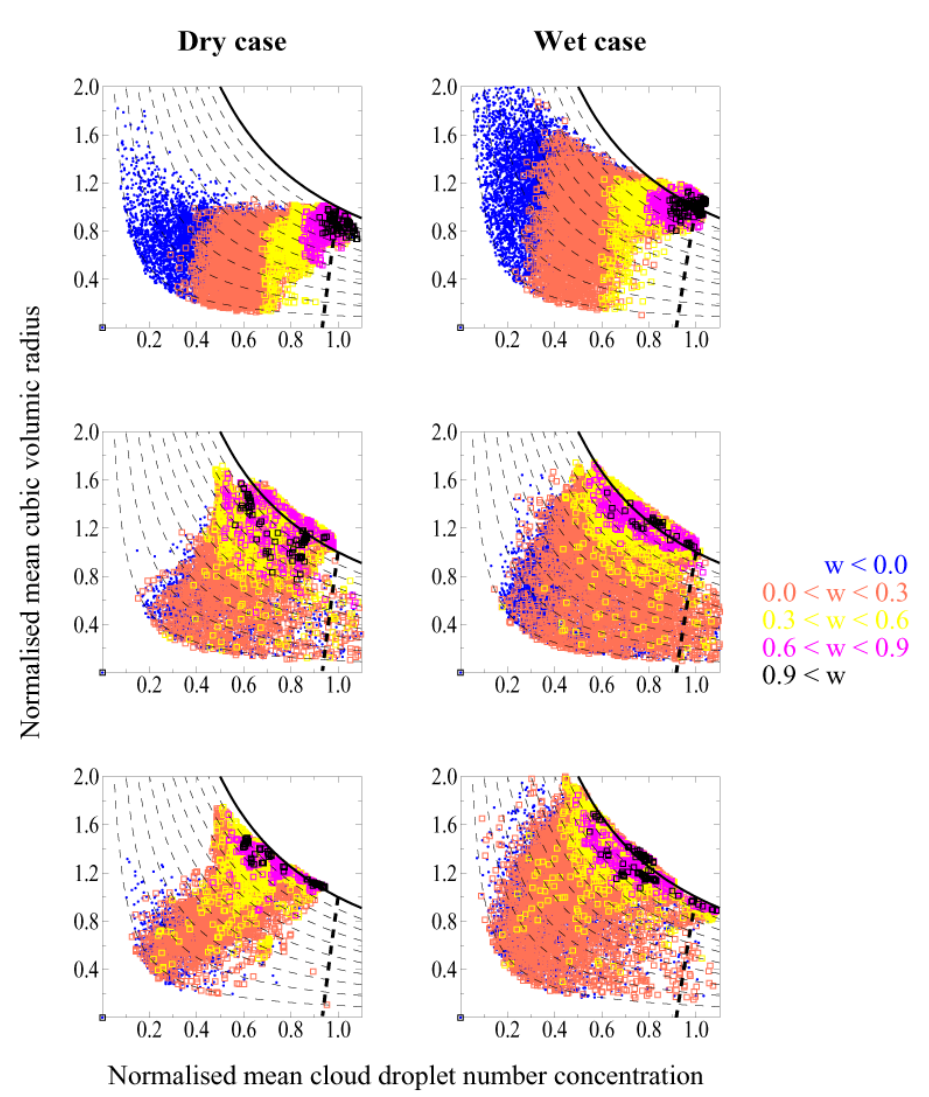
Fig. 6. Normalised mean cubic volume radius as a function of the normalised mean cloud droplet number concentration from the upper 100m of the cloud layer for the DRY (left) and the WET (right) cases. Solid and dashed lines represent values of the LWC dilution ratio (q c /q cad ) from 1% for adiabatic samples (solid curve), down to 10% (dashed curves). Thick dashed line shows the limit for pure homogeneous mixing. The colour scale corresponds to the vertical velocity in the grid